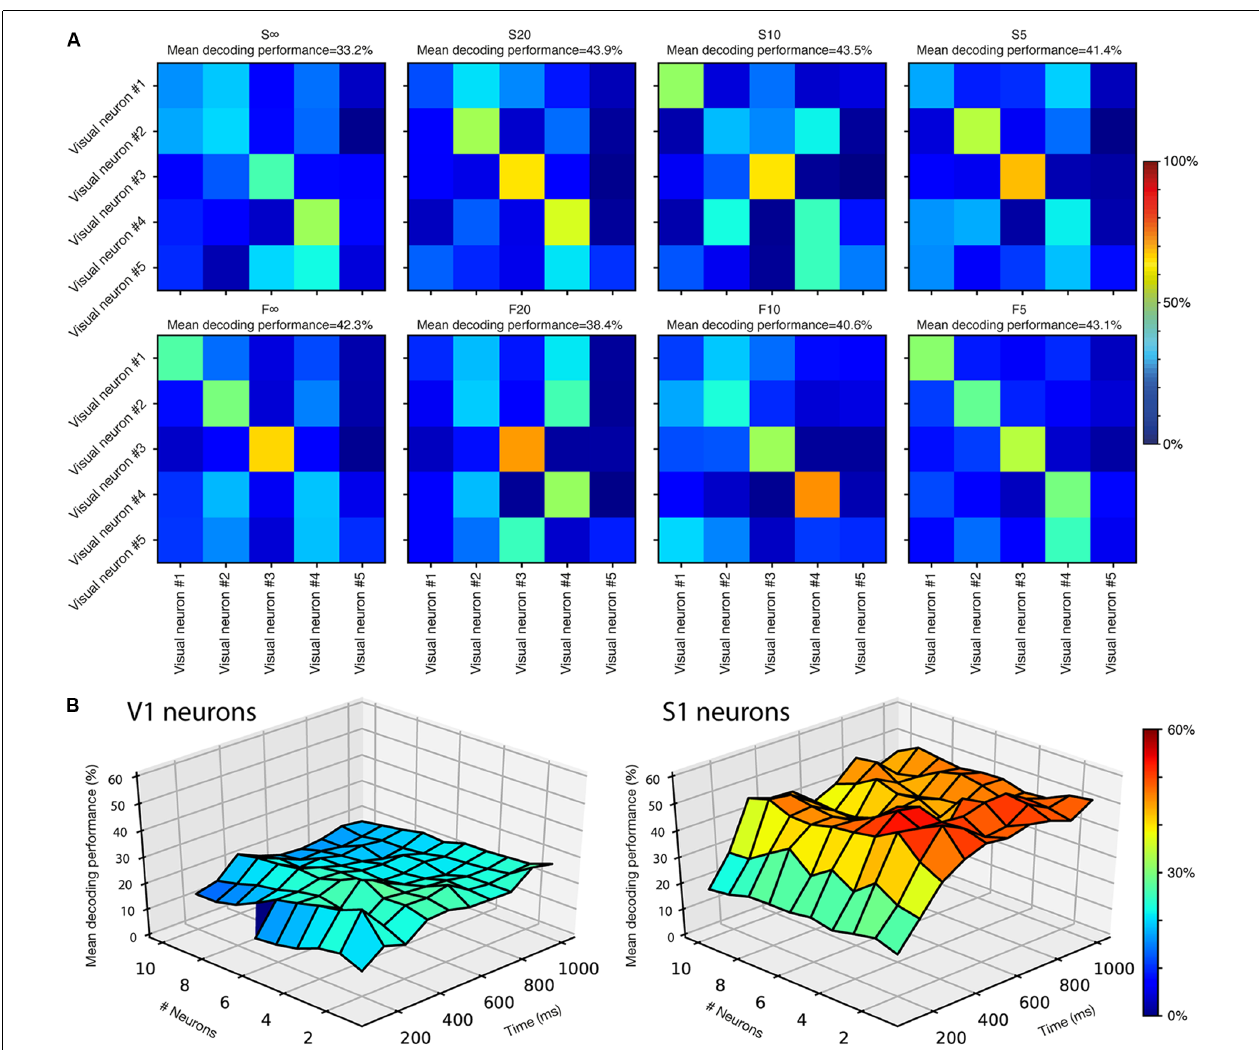
FIGURE 4 | Complementariness of the neuronal responses. (A) Decoding analysis for the differences in response patterns for the five top decoding V1 neurons when presented with the same stimulation patterns. One confusion matrix is shown for each stimulation pattern. (B) Cooperative decoding analysis for V1 neurons and S1 neurons, respectively. Note that for V1 neurons, the line at 100 ms is interrupted after six neurons, as neurons 7–10 did not provide any responses for this first time